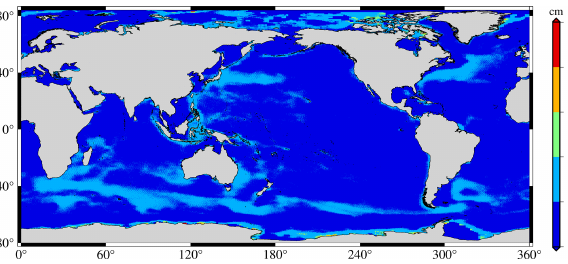
Figure 11. Formal error of the DTU18 model.